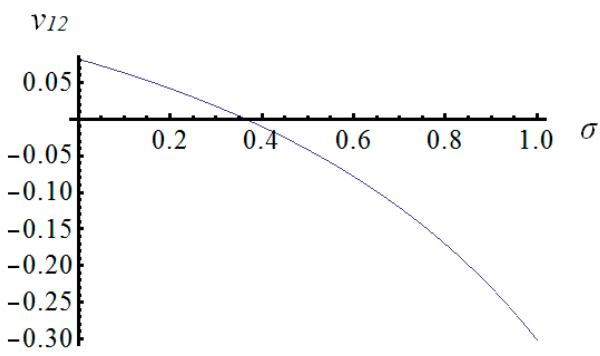
Figure 9. Poisson’s ratio ν 12 = ν 21 changing sign (the plot for k = 0.4).